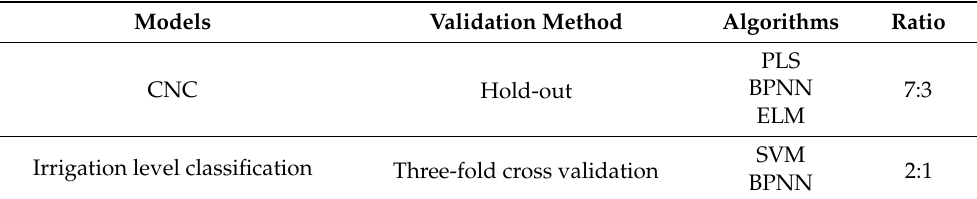
Table 3. Modeling